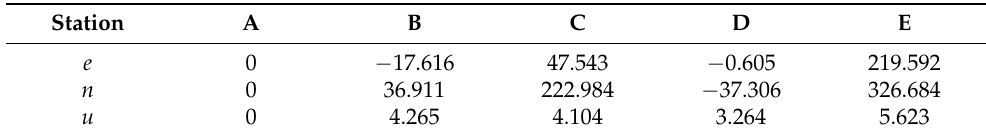
Table 3. ENU control